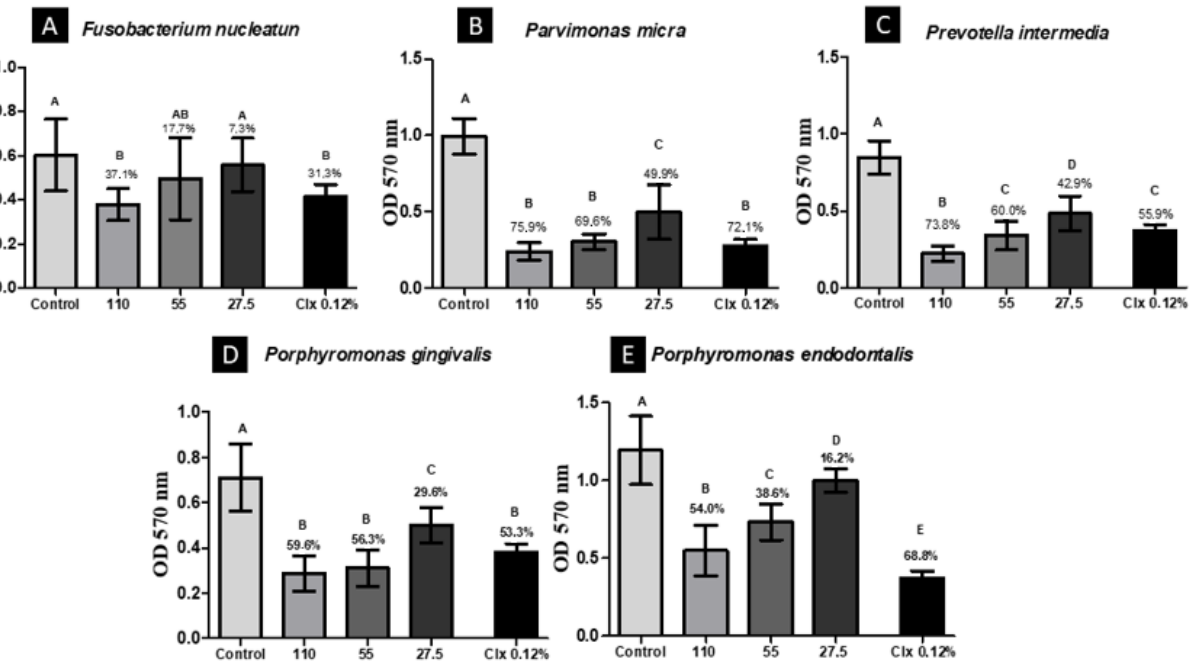
Figure 2. Biomass reduction after contact for 5 min with the BGP-AqExt. Legend: OD—Optical Density; Control: BHI broth; Clx—Chlorhexidine; Values expressed in mg/mL; Different uppercase letters (A–E) indicate statistically significant difference (ANOVA, Tukey, p < 0.05).